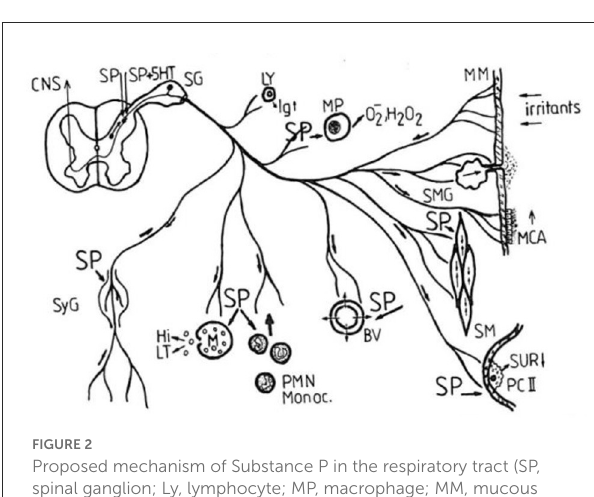
FIGURE2 Proposed mechanism of Substance P in the respiratory tract (SP, spinal ganglion; Ly, lymphocyte; MP, macrophage; MM, mucous membrane; MCA, mucociliary activity; BV, blood vessels; SM, smooth musculature; SMG, mucous gland; PC II, pneumocyte type II; SUR, surfactant; SyG, sympathetic ganglion; Hi, histamine; LT, leukotrienes; Monoc., monocytes; PMN, polymorphonuclear neutrophils; CNS, central nervous system; 5-HT serotonin)